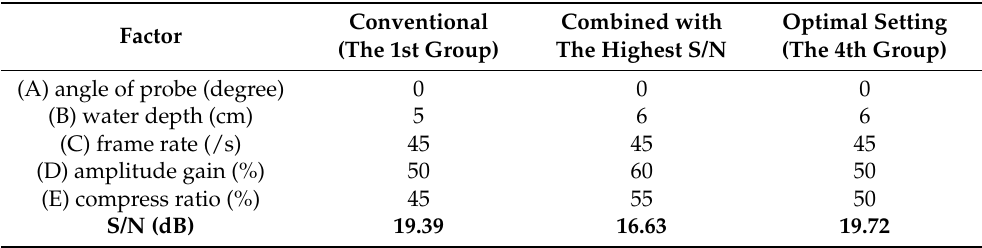
Table 5. The S/N ratio derived for the conventional (1st group), combined with the highest S/N of each factor, and the optimal setting (4th group) by sonography